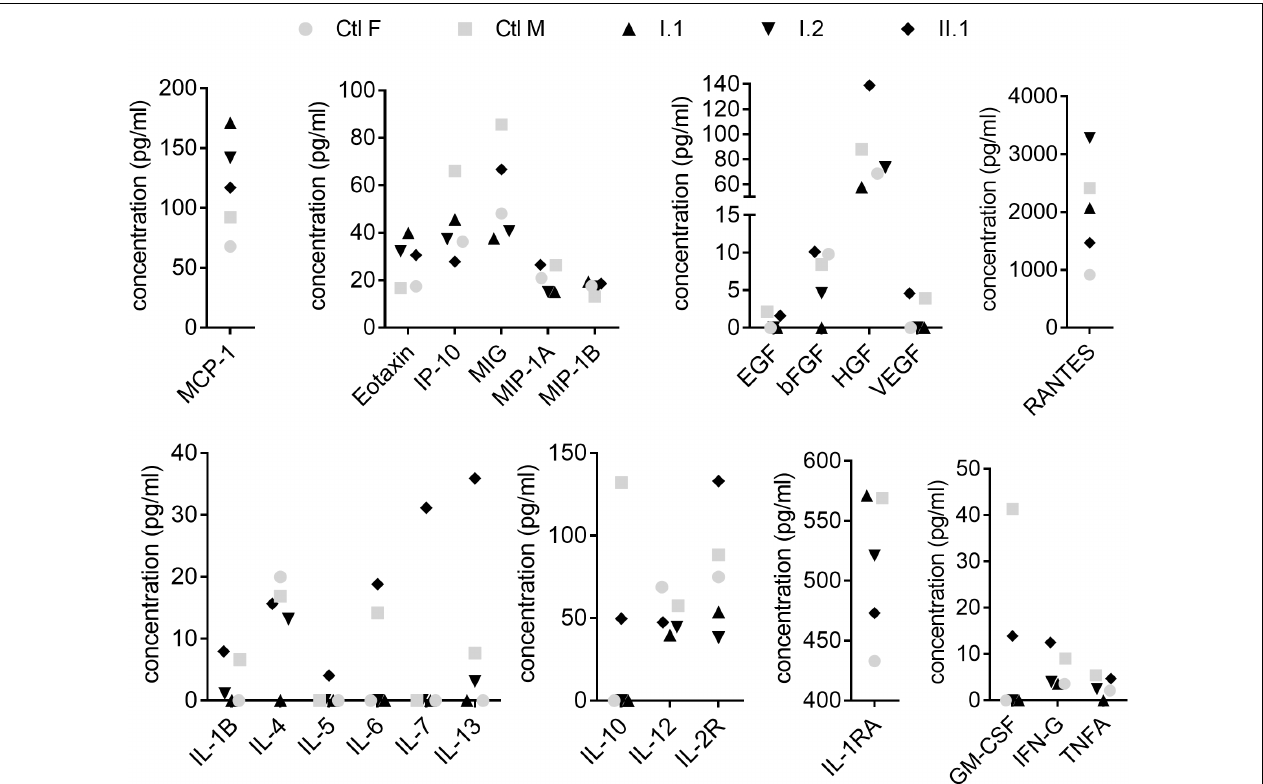
FIGURE 3 | Plasma analysis. Plasma concentration of cytokines, chemokines and growth factors were measured by Human Cytokine Magnetic 30-Plex Panel. Filled symbols indicate family members (I.1, I.2, II.1) diagnosed with c.1831C > T (p.Arg611 ∗ ) nonsense mutation. Concentrations of analytes in individuals were compared to age- and sex-matched controls (Ctl F, Ctl